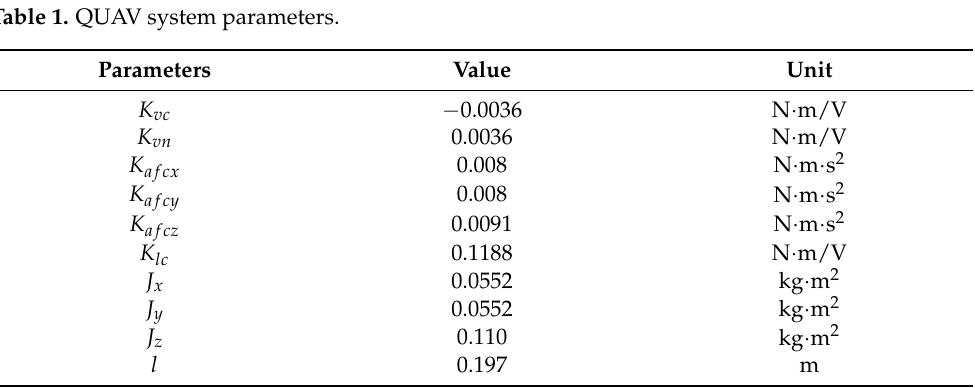
Table 1. QUAV system parameters.